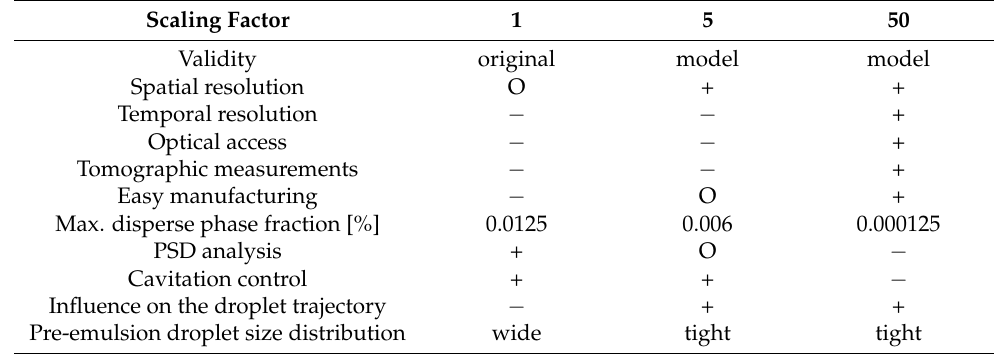
Table 2. Comparison of the advantages (+) and disadvantages ( − ) of the different tests and